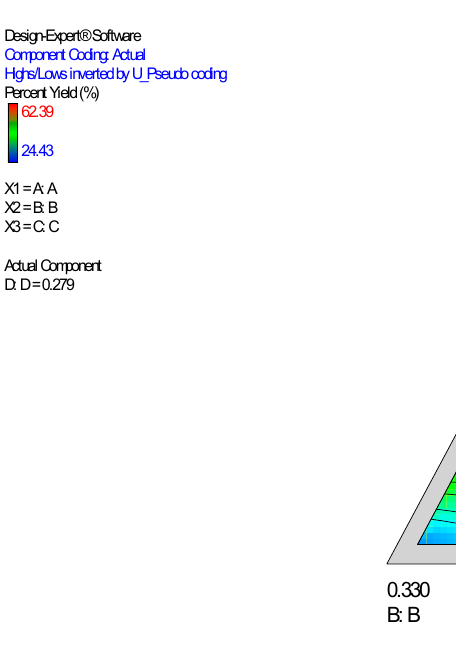
Table 5. Analysis of variance table for particle size (Poly- ε -caprolactone-based nanoparticles.